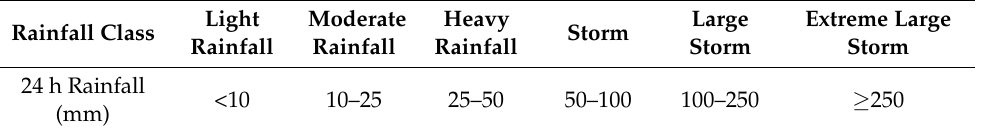
Table 3. Rainfall intensity classification